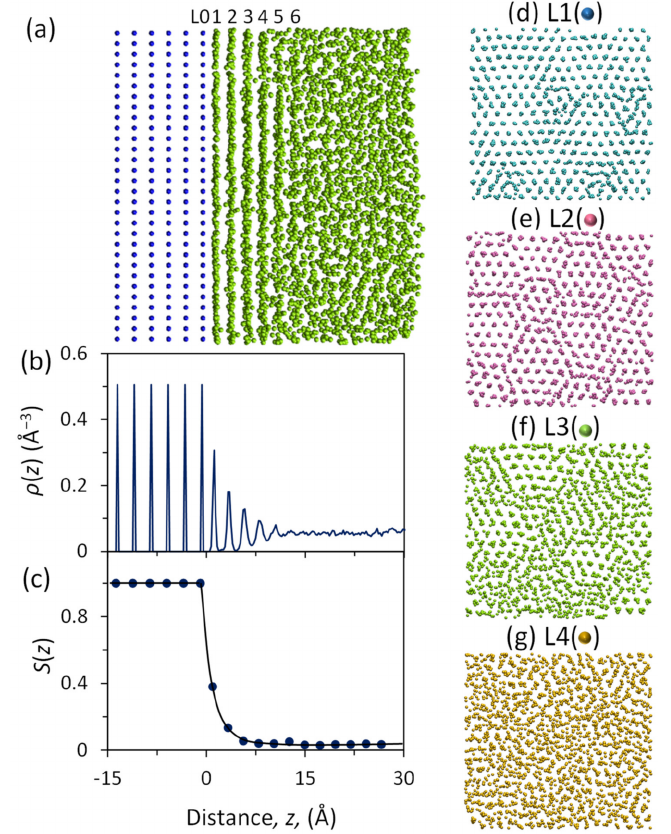
Figure 1. Precursor of heterogeneous nucleation [11]. Precursor represents the atomic arrangement at the L/N interface at the end of prenucleation or at the onset of nucleation. ( a ) A snapshot, and ( b ) atomic density profile, ρ (z), and ( c ) in-plane order parameter, S ( z ), as a function of the distance, z , from the substrate surface ( z = 0 Å) for the simulation system with − 8% misfit at t = 0 ps and T n = 760 K. There are 6 notable atomic layers in the liquid, but only the first three layers contain some degree of in-plane ordering. ( d – g ) show the time-averaged atomic positions in the first (L1), second (L2), third (L3) and forth (L4) layers at the L/N interface. It exhibits substantially ordered structure in the L1 and L2, and less ordered in the L3, and disordered in the